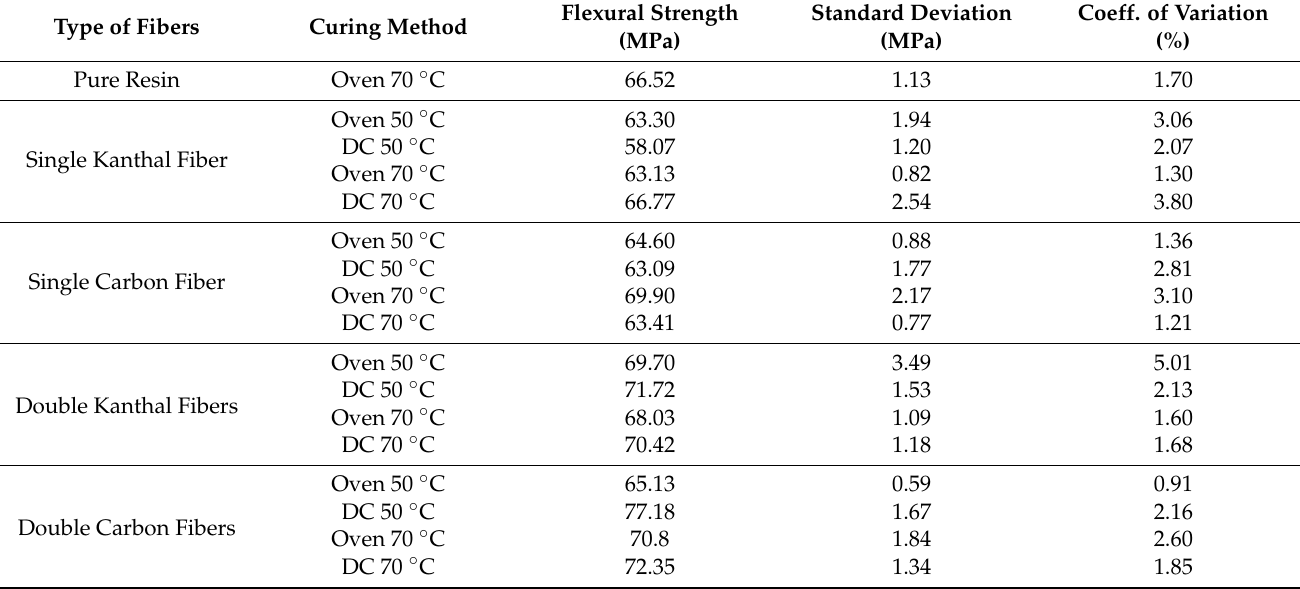
Table 1. Statistical analysis of flexural strength values for different curing methods.